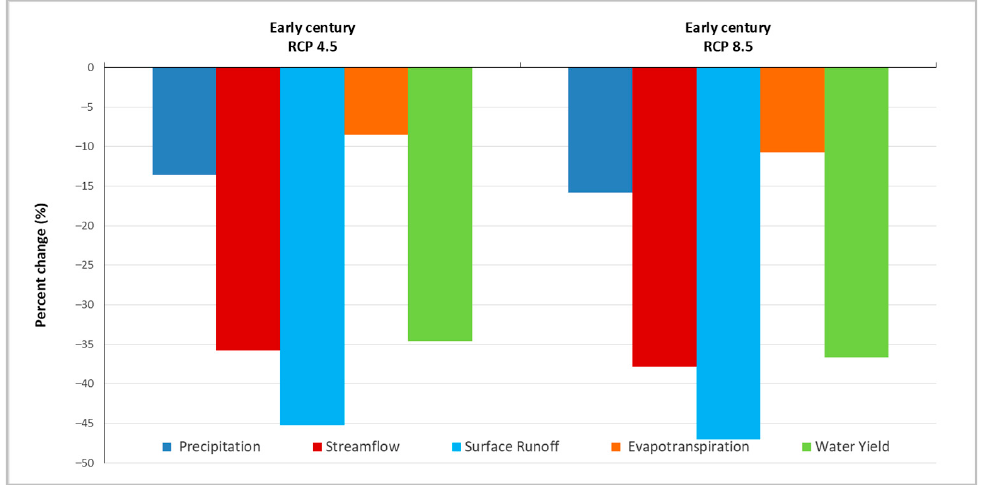
Figure 12. Simulated mean annual changes to key water balance components using the delta ‐ change method.